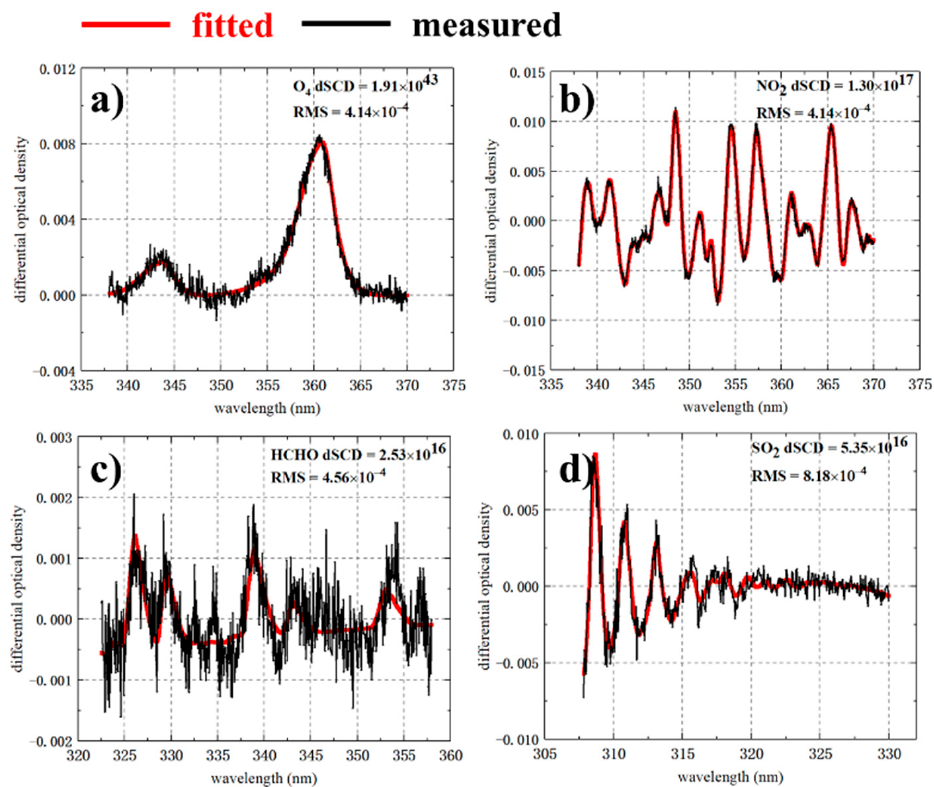
Figure 2. The DOAS spectral fittings example: ( a ) O 4 , ( b ) NO 2 , ( c ) HCHO and ( d ) SO 2 . Red line and black line represent absorption signal and absorption of the target species, respectively.